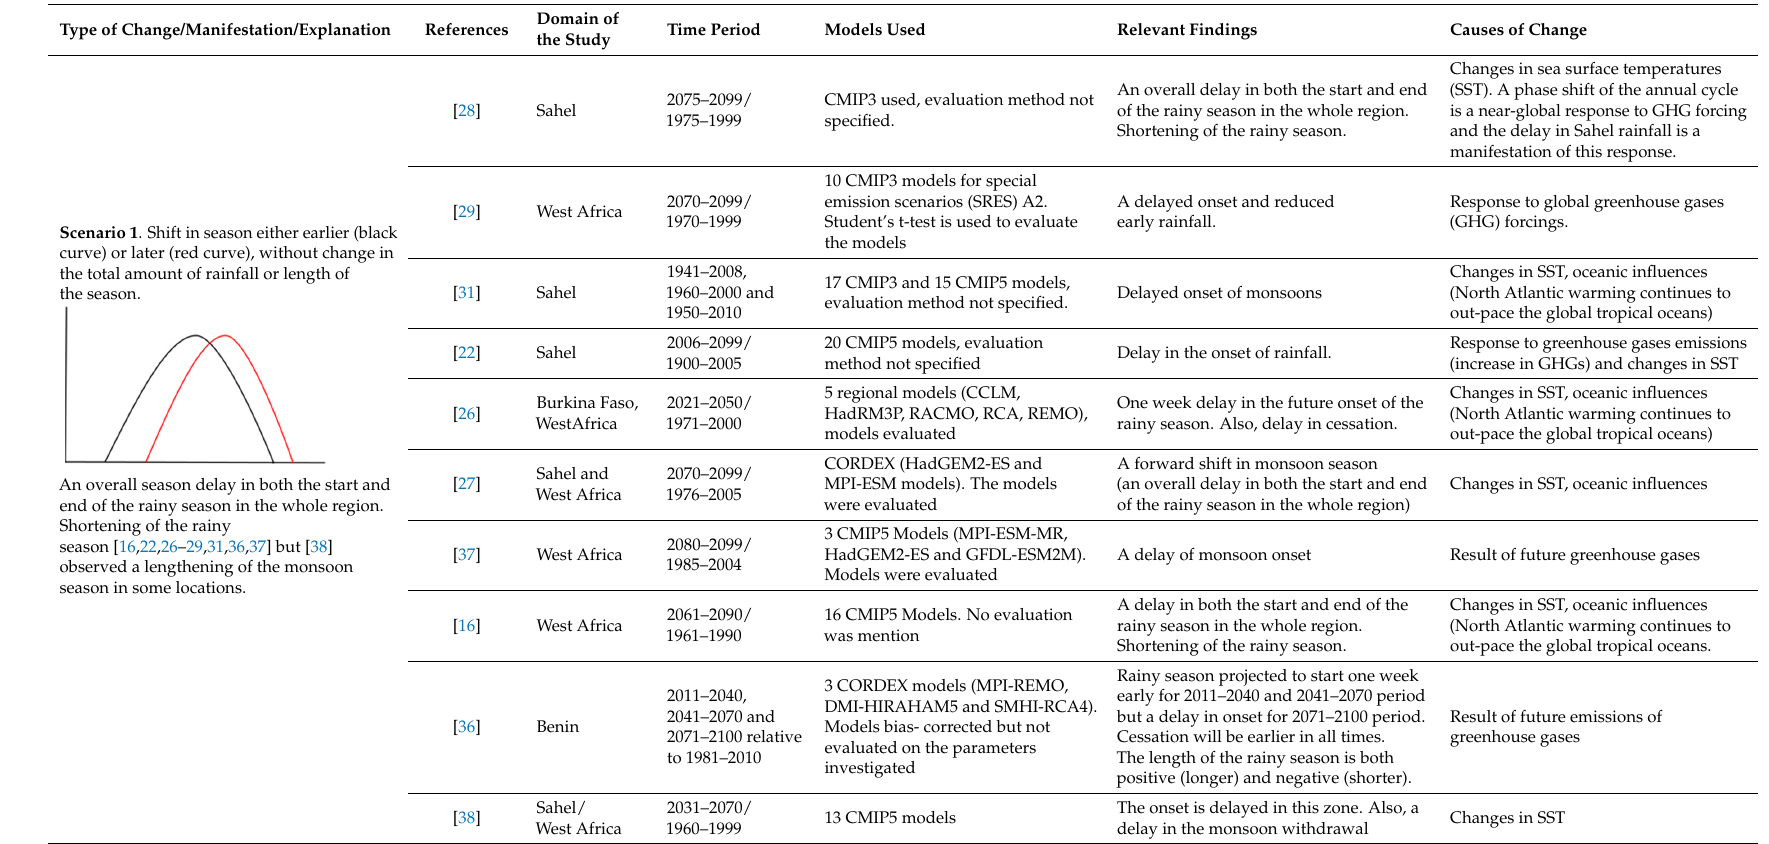
Table 1. The conceptual framework.